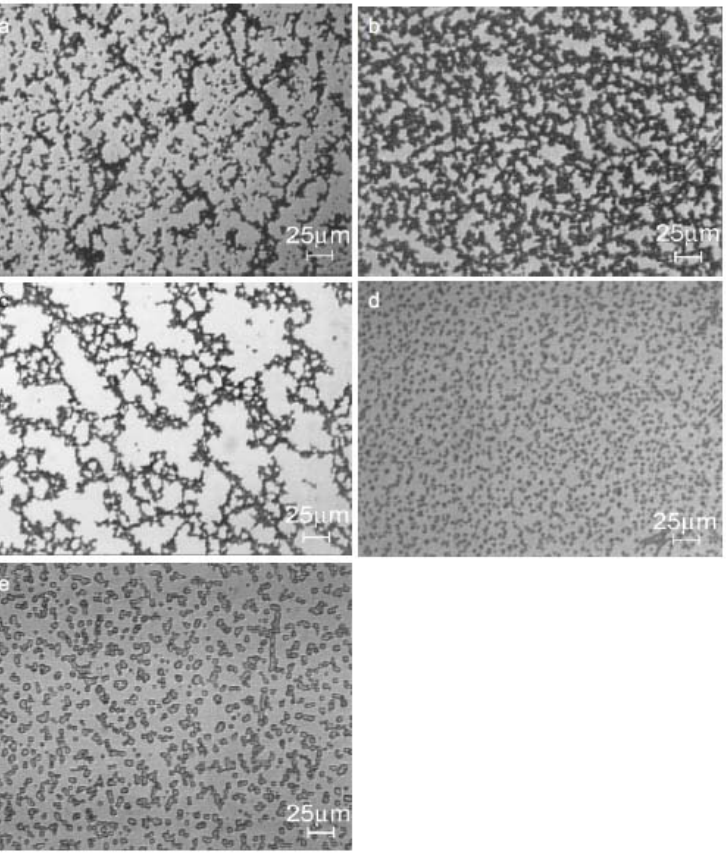
Figure 38. Optical microscope images of 1 wt % MWSNTs/PP composite films. The character of the CNTs dispersion was governed by surface modification via octadecylamide functionalization or surfactant adsorption: a) MWCNTs/PP; b) functionalized MWCNTAS/PP; c) MWCNTS/PP with NP-9; d) MWCNTS/PP with Triton-100, e) functionalized MWCNTS/PP with Disperbyk-163. Reproduced with permission from ref.